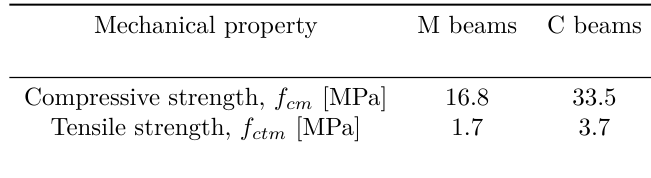
Table 2. Mechanical property of concrete.